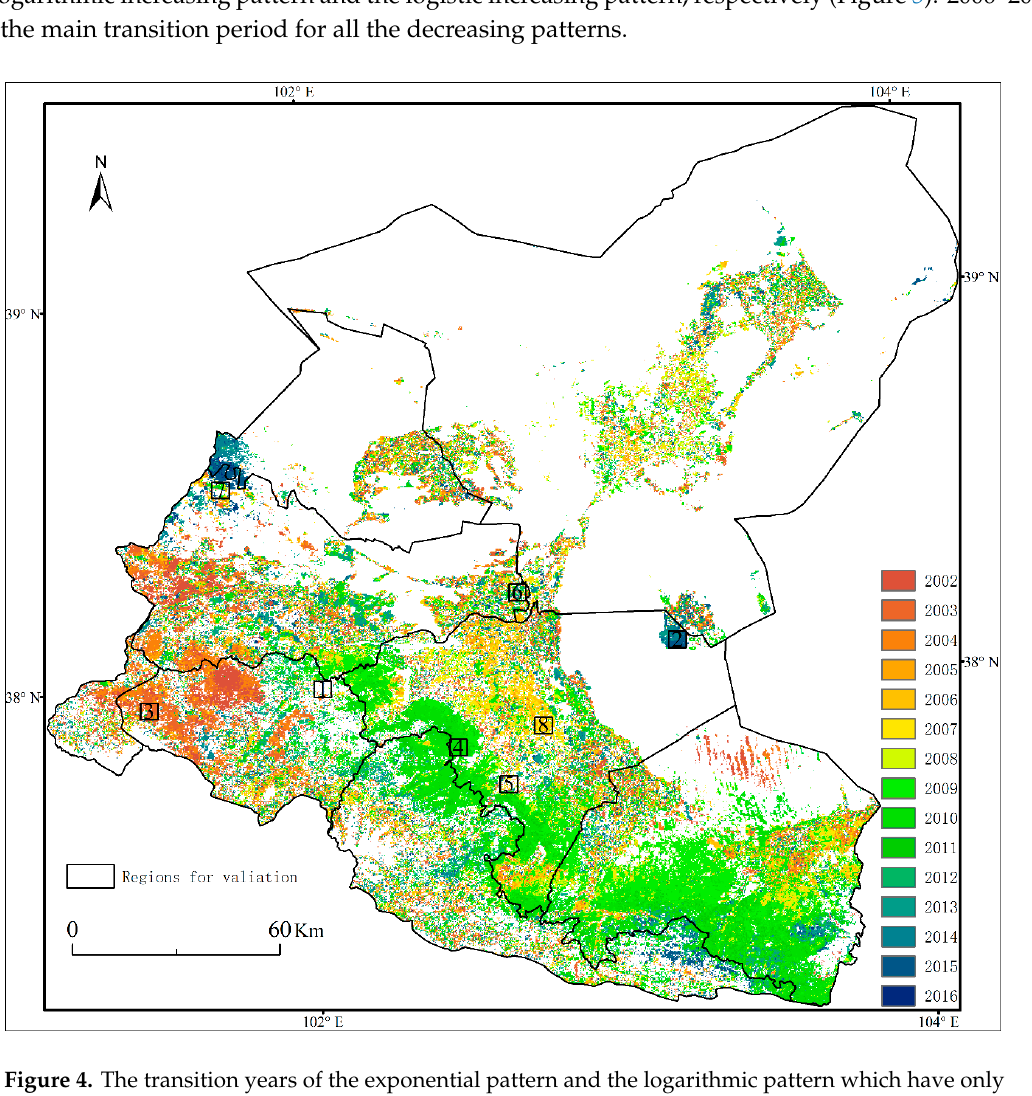
Figure 5. The number of pixels in each individual year for the patterns II–IV (increasing trends) and Ⅵ – Ⅷ (decreasing trends).